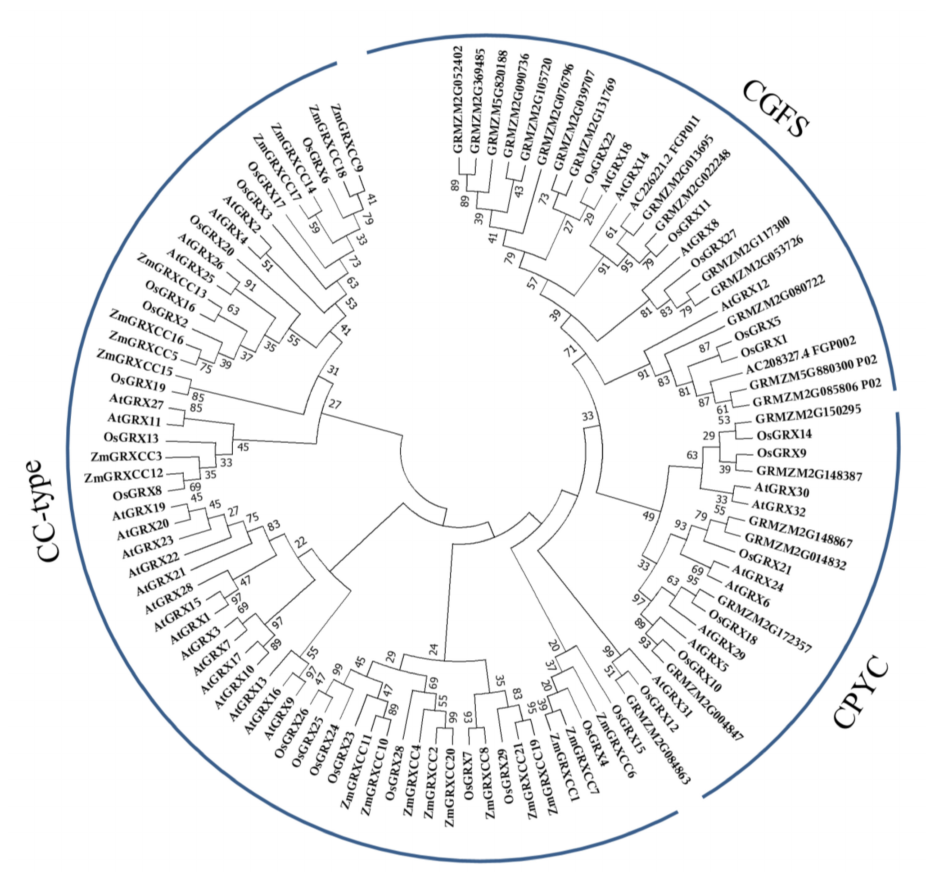
Figure 1. Phylogenetic tree of glutaredoxins (GRXs) from maize, rice, and Arabidopsis . Members of GRXs were classified by their redox activity site. The names used for GRX genes in rice and Arabidopsis followed the report of Garg et al.